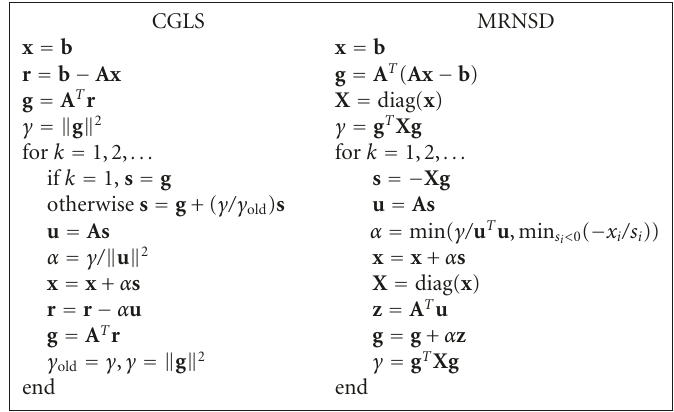
Figure 4: The step sequences describing the restoration